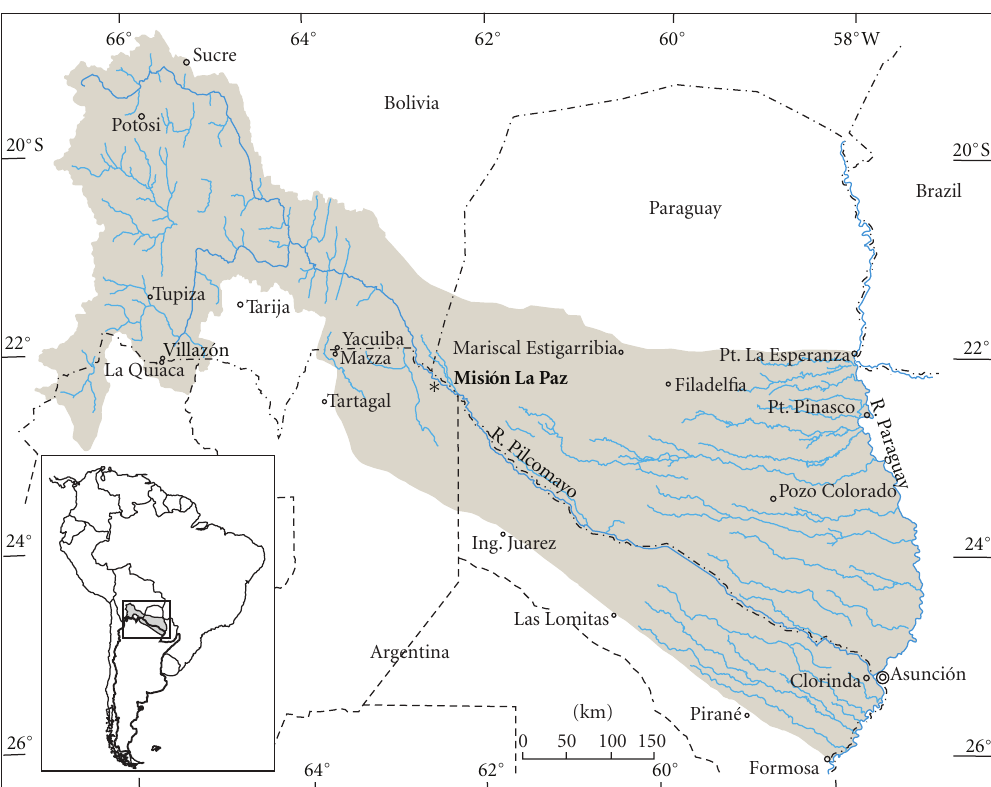
after acid digestion (HNO 3 :HClO 4 :HF:HCl). Method